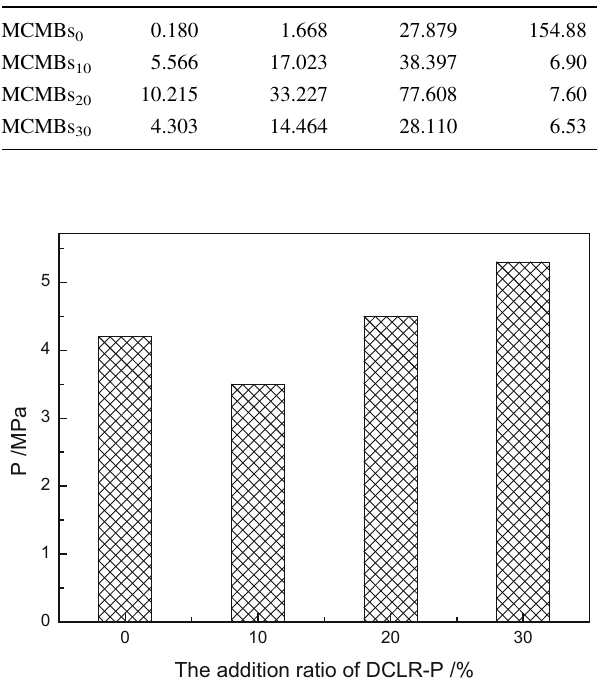
Fig. 3 Variation of terminal pressure with different ratios of DCLR- P